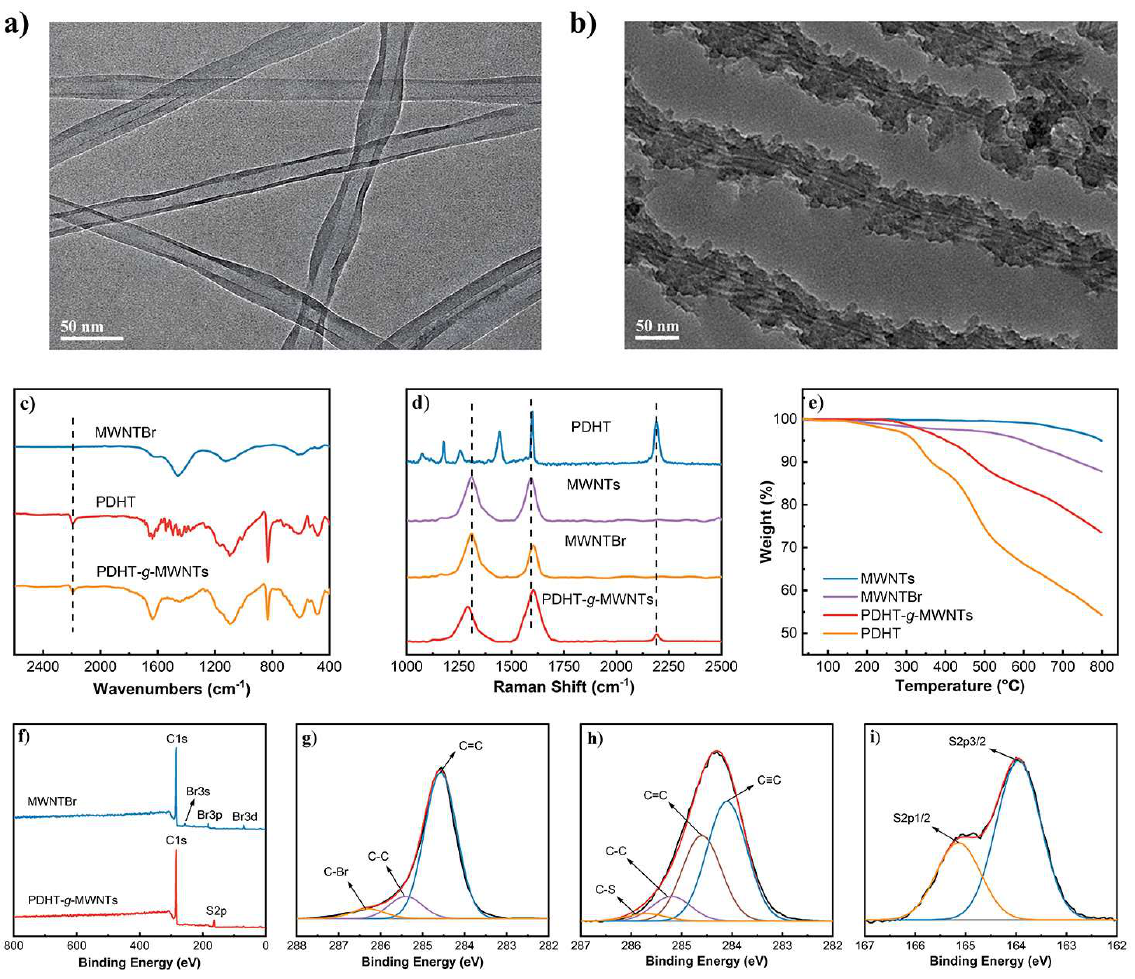
Figure 1. ( a ) The TEM picture of MWNTs. ( b ) The TEM picture of PDHT- g -MWNTs. ( c ) FTIR spectra of MWNTBr, PDHT, and PDHT- g -MWNTs. ( d ) Raman spectra of the samples ( λ ex = 514 nm). ( e ) TGA diagrams of MWNTs, MWNTBr, PDHT, and PDHT- g -MWNTs. ( f ) XPS wide-scan spectra of MWNTBr and PDHT- g -MWNTs, ( g ) C 1s core-level spectra of MWNTBr, ( h ) C 1s and ( i ) S 2p core- level spectra of PDHT- g -MWNTs.